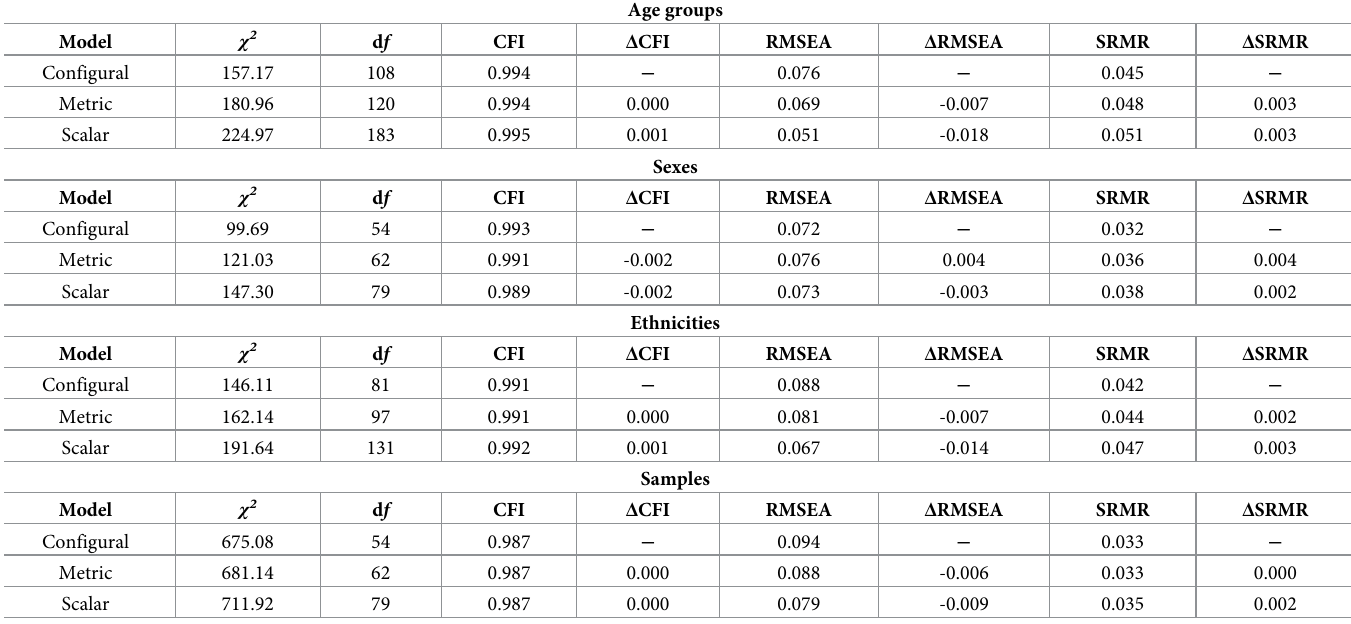
Table 1. Summary of measurement invariance analysis.